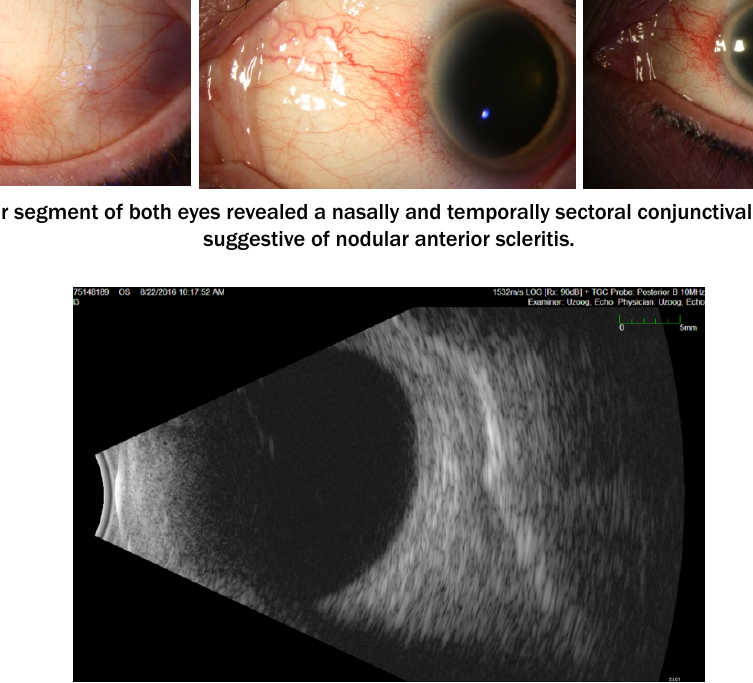
Figure 2: B-scan ultrasonography revealed no fluid in Tenon’s capsule, excluding posterior